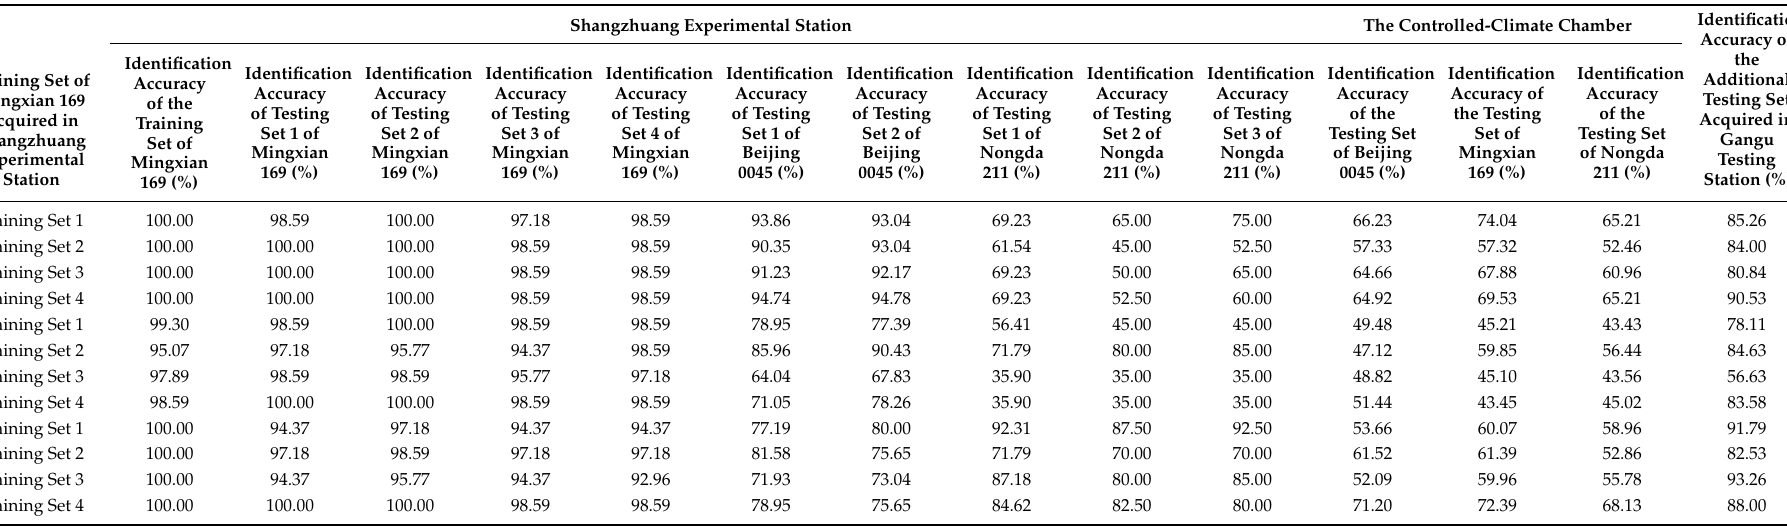
Table 12. Identification results for the individual-variety disease image testing sets acquired in the wheat field in Shangzhuang Experimental Station and under laboratory environmental conditions, and the additional testing set consisting of multi-variety disease images acquired in the wheat field in Gangu Testing Station using the SVM, BPNN, and RF models, built based on the different training sets of the variety Mingxian 169, consisting of disease images acquired in the wheat field in Shangzhuang Experimental